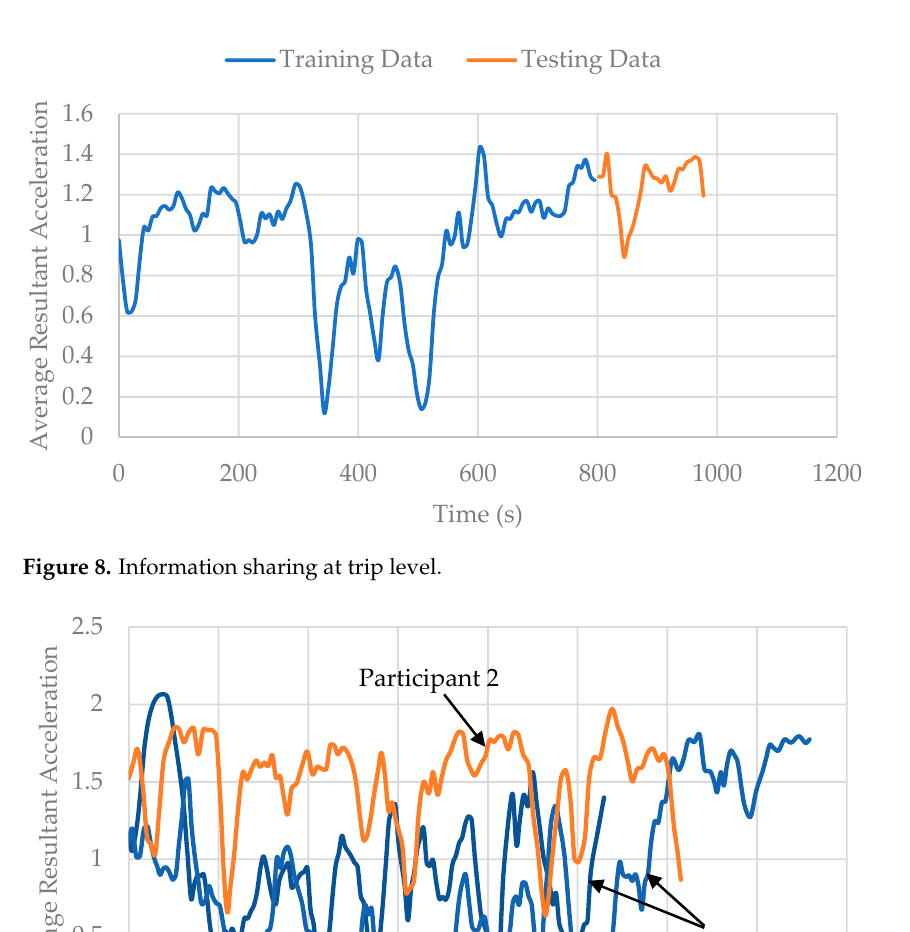
Figure 7. Information sharing at data level.